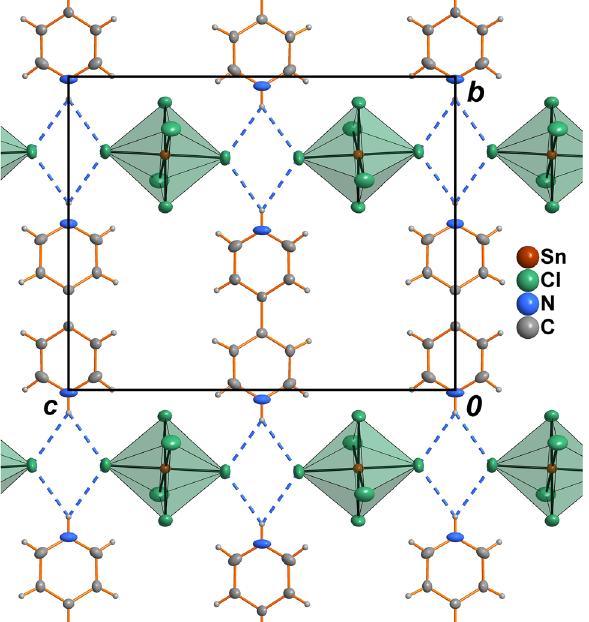
Table  : Data collection and